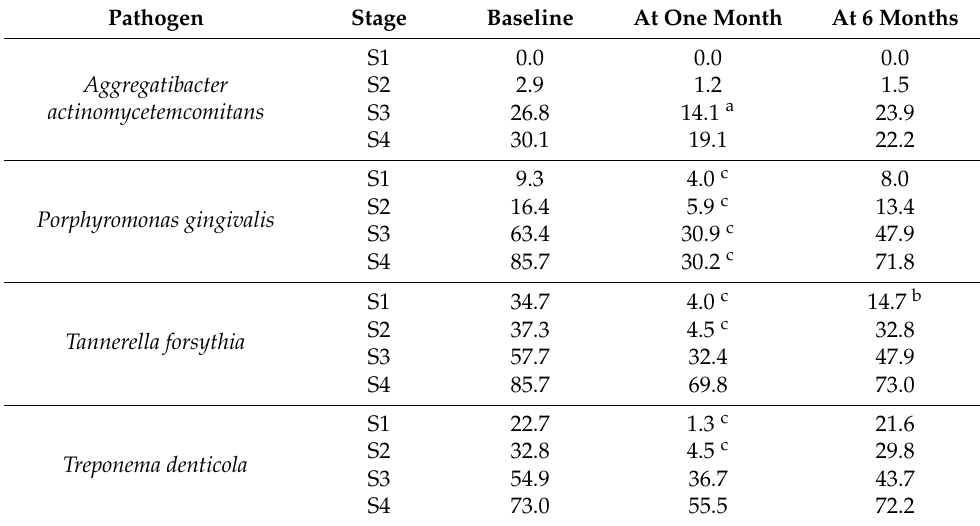
Table 8. Periodontal pathogens detection at baseline and after treatment (one month and six months) for the CHX